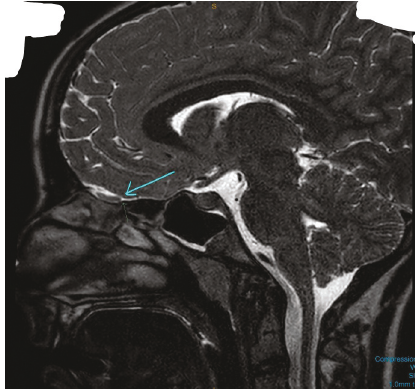
Figure 1: T2-weighted high-resolution image of the MRI brain anosmia protocol sagittal view showing normal volume olfactory bulb with sudden termination and discontinuation, suggesting olfactory tract agenesis (blue